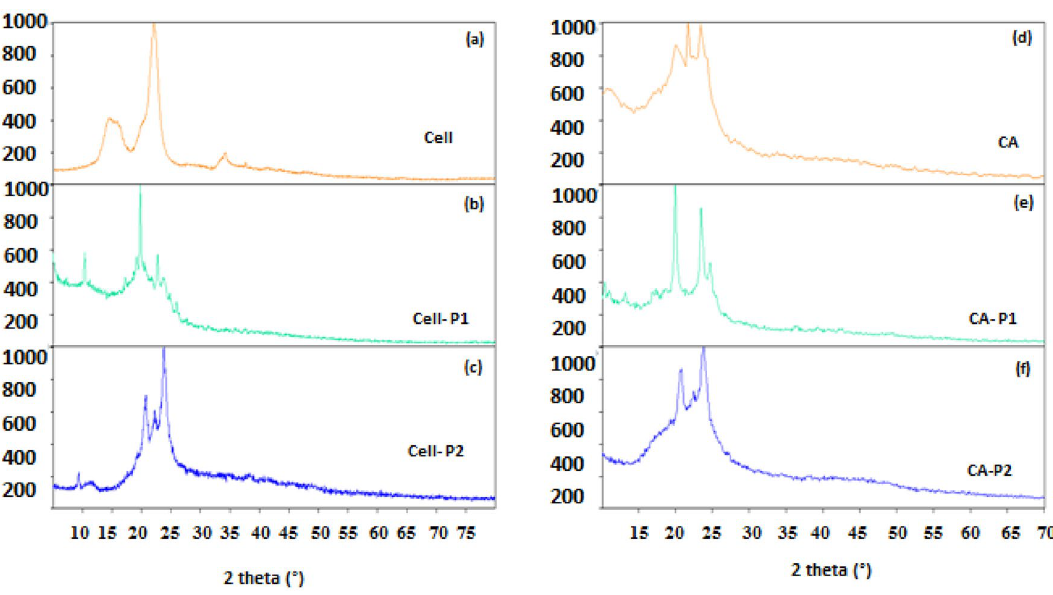
Figure 7. XRD spectra for ( a ) cellulose, ( b ) Cell-P 1 , ( c ) Cell-P 2 , ( d ) CA, ( e ) CA-P 1 , and ( f ) CA-P